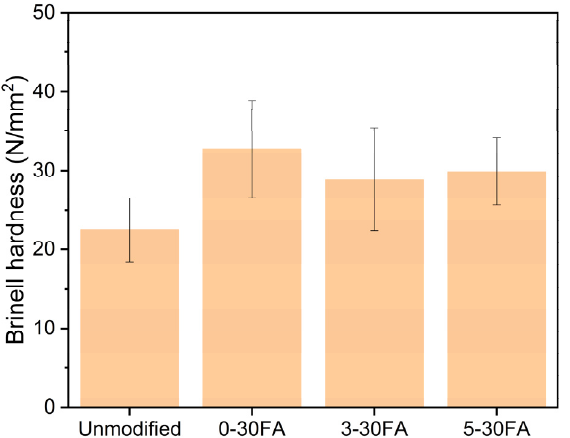
Figure 10. Radial surface Brinell hardness values of the unmodified wood specimen and of the 0-30FA, 3-30FA, and 5-30FA modified specimens.